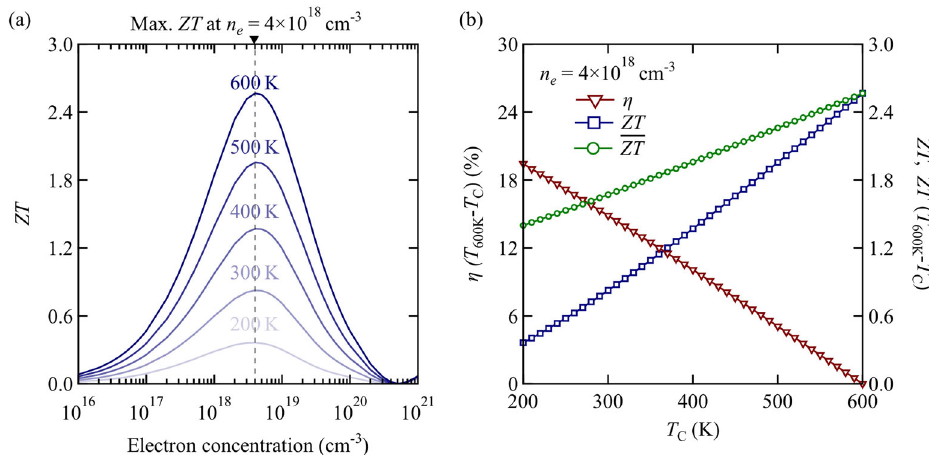
Fig. 4 ZT and ef fi ciency prediction. a Predicted ZT values of Cs 3 Cu 2 I 5 as a function of temperature and carrier concentration. b Estimated thermodynamic ef fi ciency ( η , brown triangles) and average ZT ( ZT , dark green circles) at electron concentration ( n e ) of 4 × 10 18 cm − 3 over temperature range of T C – T H . T H is fi xed as 600 K. ZT at the given temperature is indicated by navy